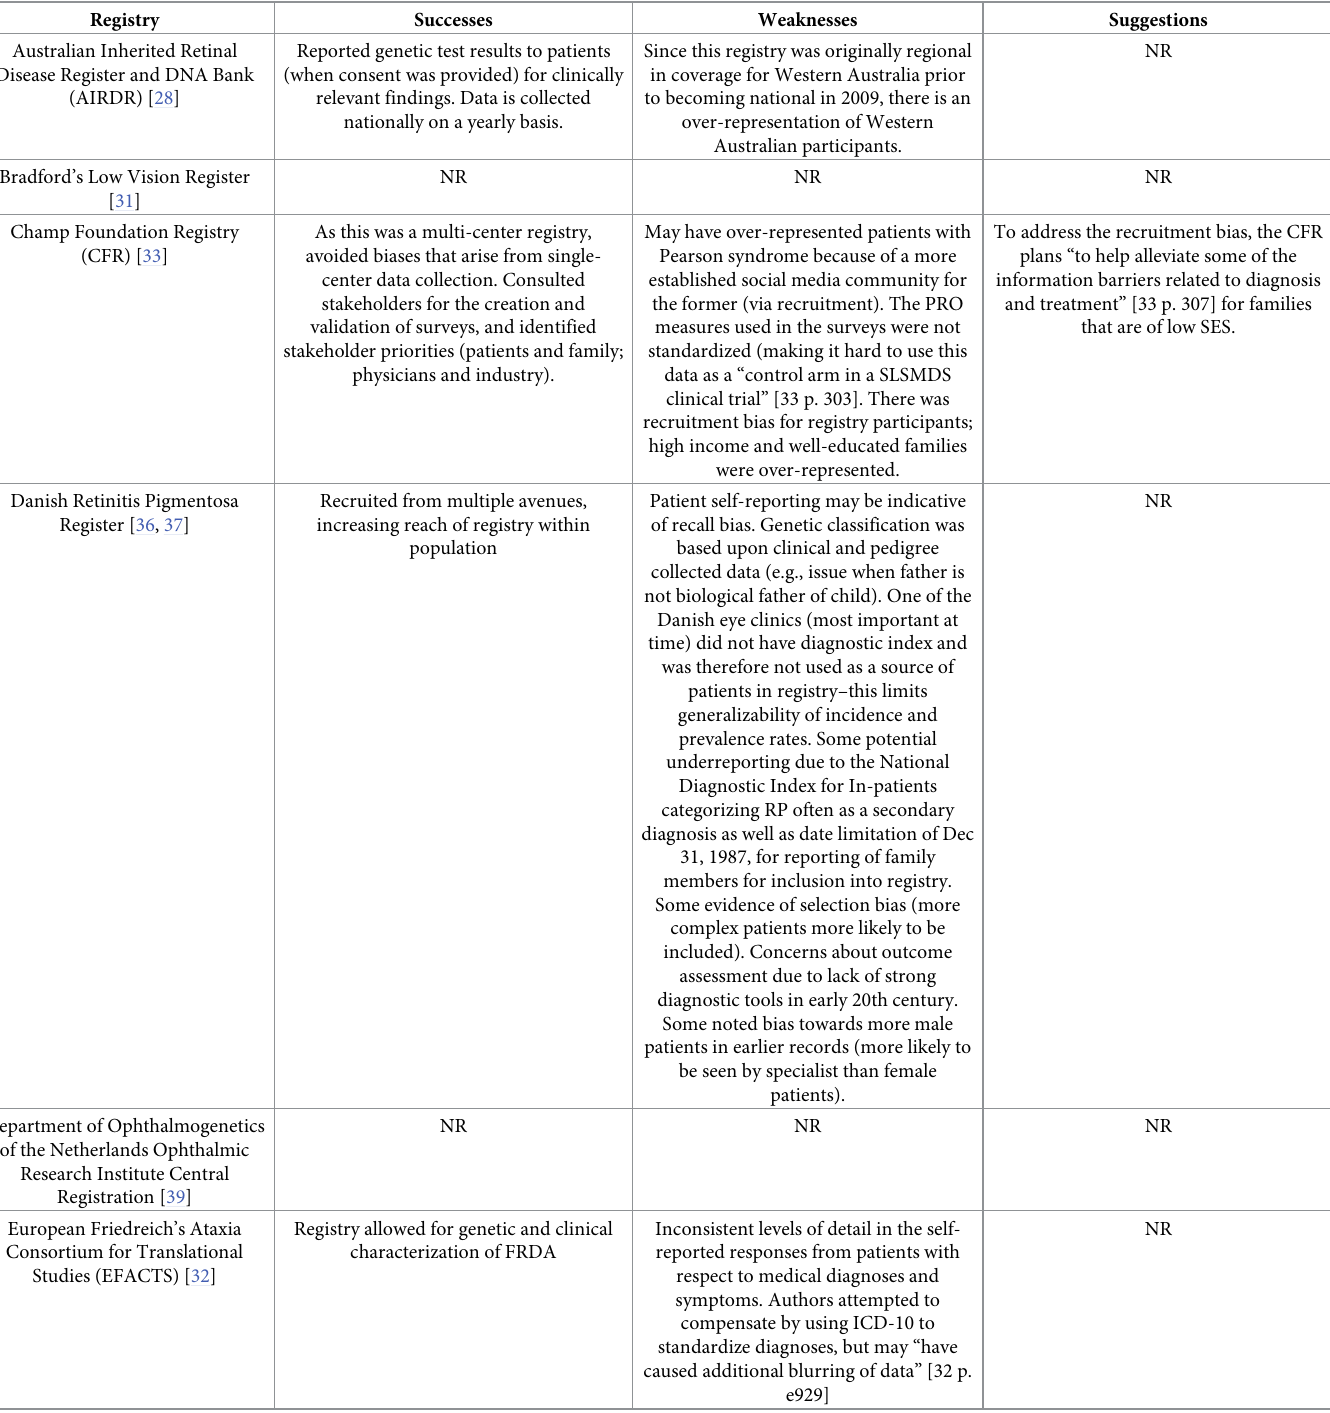
Table 4. Mitochondrial Disease (MD) patient registries’ reported successes, weaknesses, and